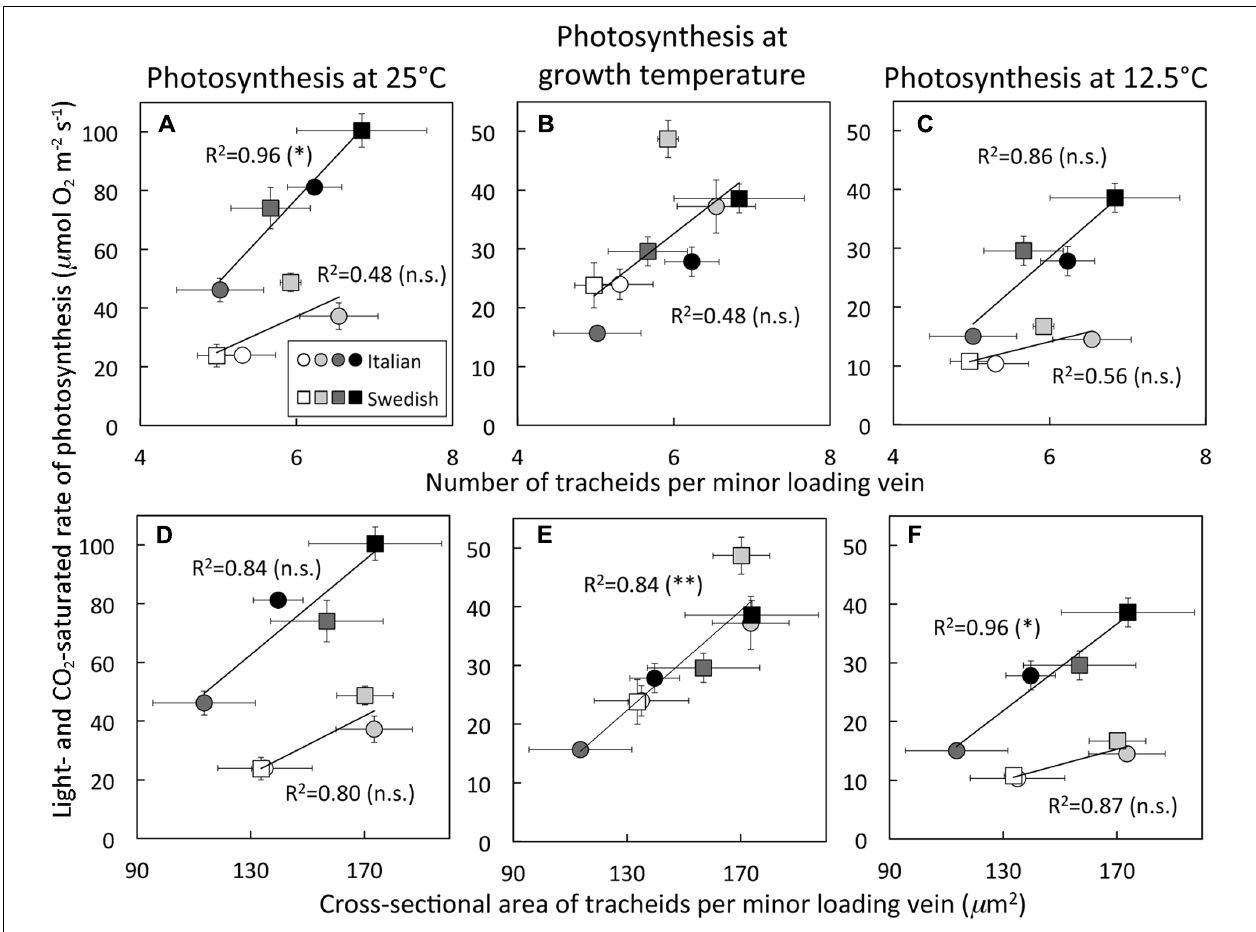
FIGURE 5 | Light- and CO 2 -saturated rate of oxygen evolution, determined at either 25 or 12.5 ◦ C, versus (A–C) the number of tracheids per minor loading vein or (D–F) the cross-sectional area of tracheids per minor loading vein for Italian (circles) and Swedish (squares) ecotypes of A. thaliana grown at two leaf temperatures and two PFDs. Plants were grown under four different conditions (24–26 ◦ C and 400 μ mol photons m − 2 s − 1 , open symbols; 24–26 ◦ C and 1000 μ mol photons m − 2 s − 1 , light gray symbols; 12–16 ◦ C and 400 μ mol photons m − 2 s − 1 , dark gray symbols; 12–16 ◦ C and 1000 μ mol photons m − 2 s − 1 , black symbols). Mean ± standard deviation shown for light- and CO 2 -saturated rates of photosynthetic oxygen